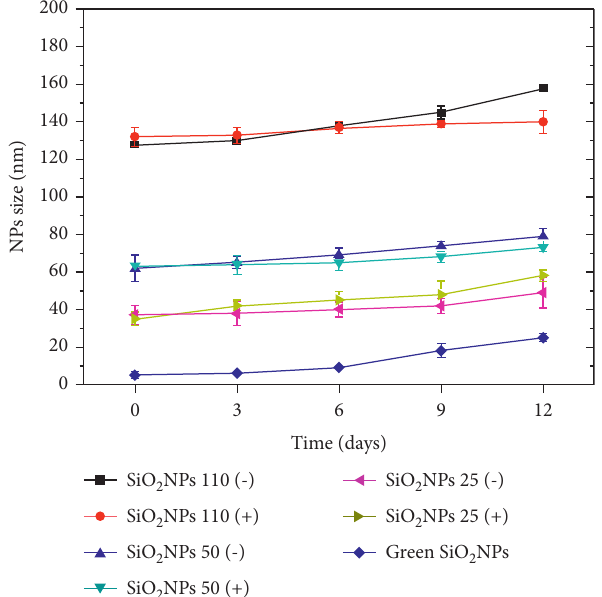
Figure 6: Stability studies of SiO − ), SiO 2 NPs 110 ( 2 NPs 110 (+), SiO 2 NPs 50 ( − ), SiO 2 NPs 50 (+), SiO 2 NPs 25 ( − ), and SiO 2 NPs 25 (+) in DMEM acquired after 0, 3, 6, 9, and 12 days. The mea- surements were performed using the DLS